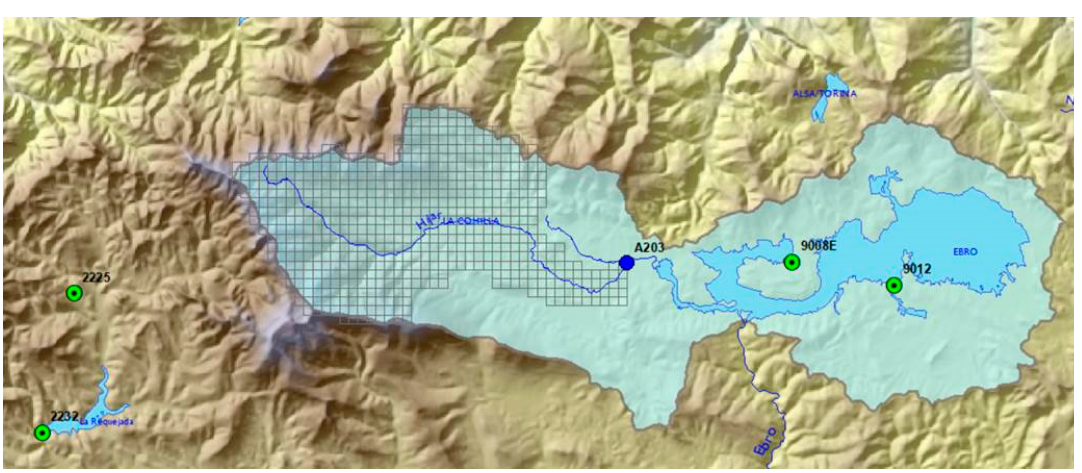
Figure 6. ASTER hydrological model. Hijar river basin mesh (grey grid), Gauging Station (A203), rainfall stations (9008E, 9012) and temperature stations (2225, 2232).